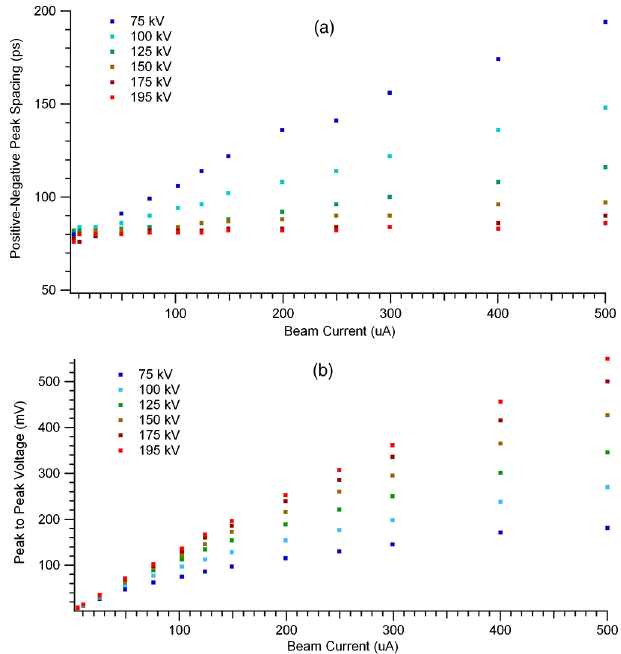
FIG. 5. (a) The spacing of the positive and negative peaks as a function of beam current and photogun bias voltage. (b) The sensitivity of the cavity bunch-length monitor as a function of average beam current and photogun bias